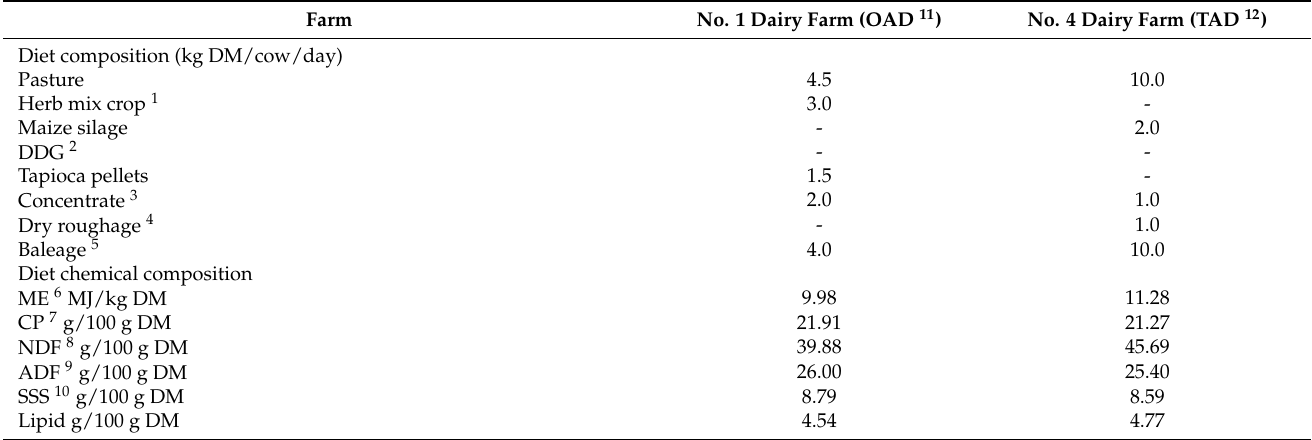
Table 1. Dietary and chemical composition of feed offered at the No. 1 and No. 4 Dairy farms during the sampling periods (late lactation) in the 2020–2021 production